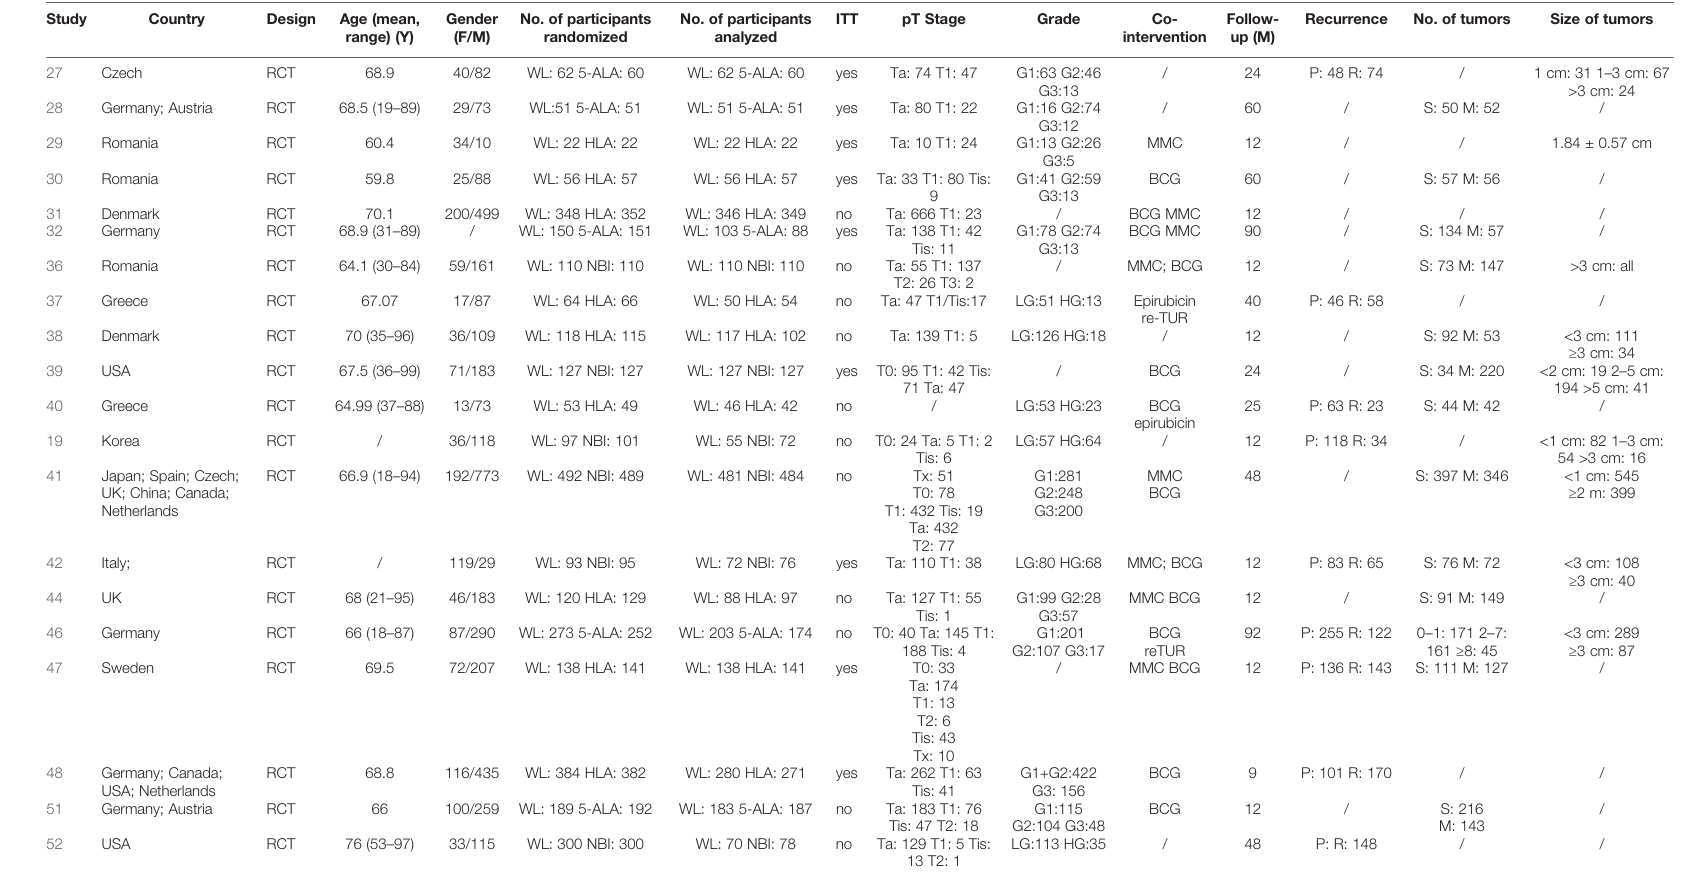
TABLE 1 | The characteristics of included studies.